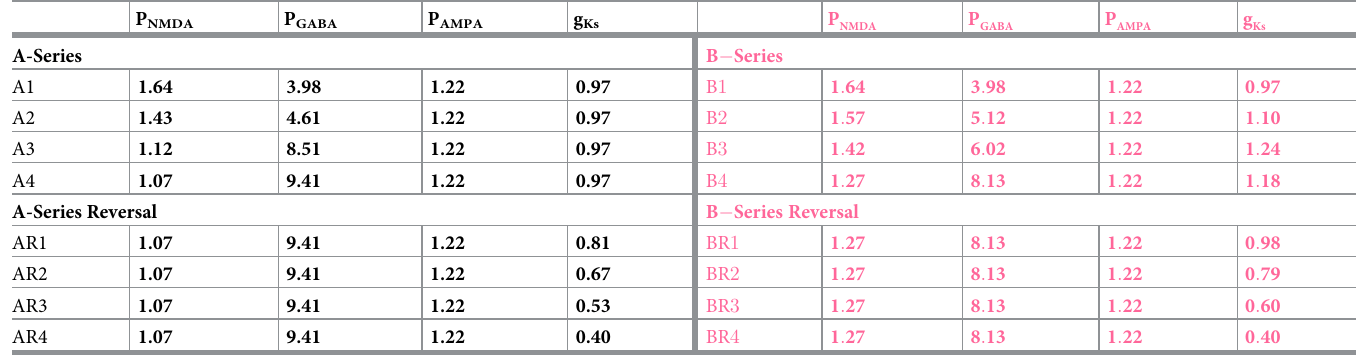
Table 2. Parameter values for best fit of simulated anesthesia and cholinergic reversal. Parameters from lowest cost fit (cost averaged across anesthetic levels) used to simulate anesthetic effects and cholinergic reversal. A/B-Series describe optimal values of best fit determined by the differential evolution algorithm for network